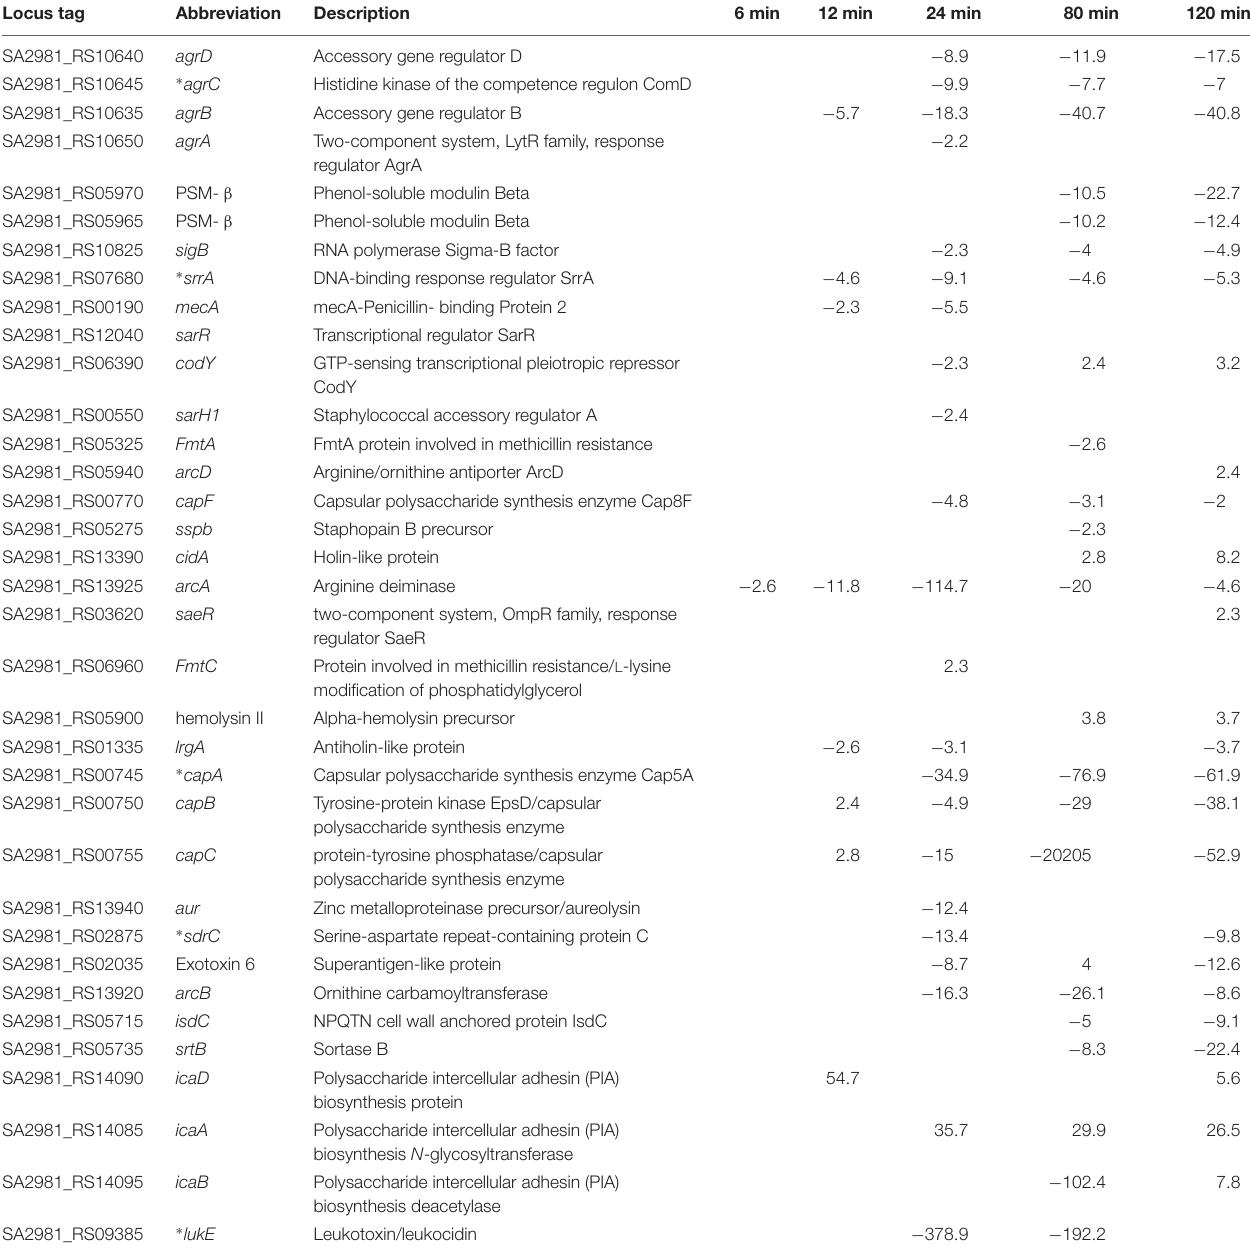
TABLE 2 | Differential expression of biofilm, and virulence-associated genes in S. aureus 04-02981 on exposure to AGXX R (cid:13) . Locus